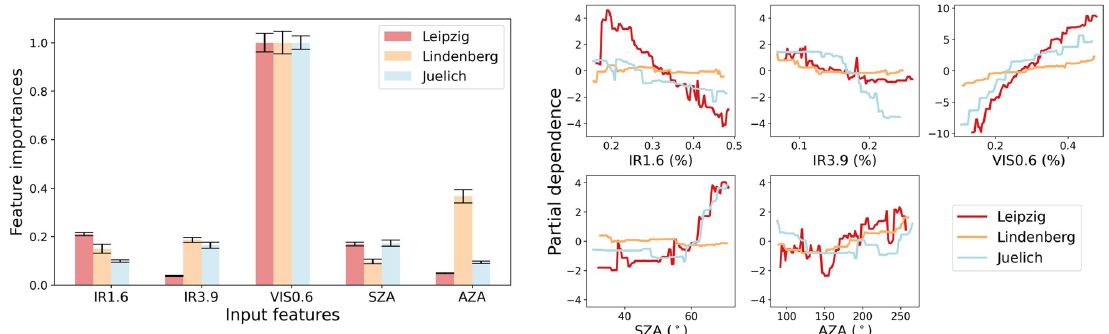
Figure 8. Feature importance ( left ) and partial dependence plot ( right ) for training data for homogeneous cloud fields with feature selection. The y -axis of the partial dependence plot shows the changes of LWP (in units of LWP) relative to the mean prediction (centered around zero) for each grid value on the x -axis.